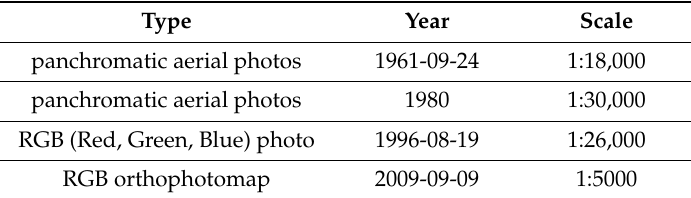
Table 2. Photogrammetric materials used for